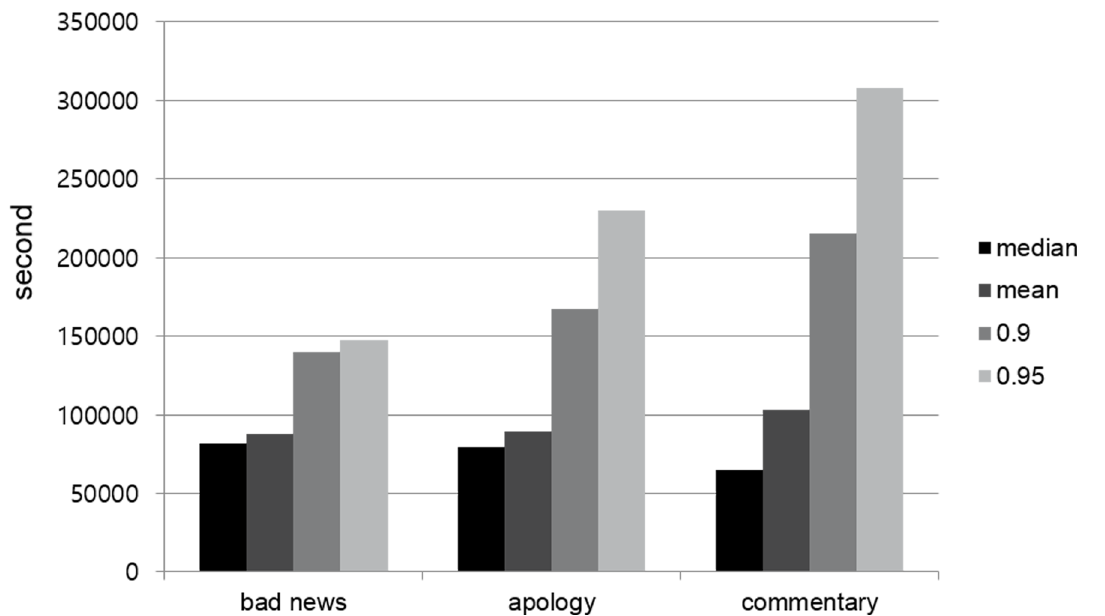
Fig 4. Cumulative distribution function of social diffusion times within